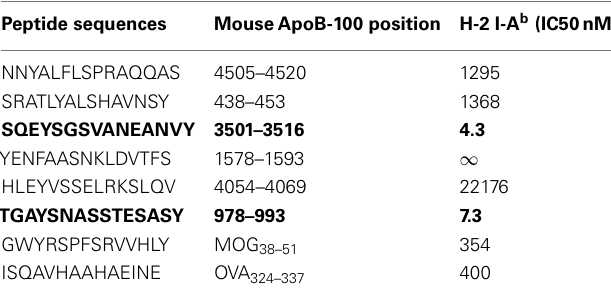
Table 1 | Peptide sequences and I-A b binding affinity as determined by